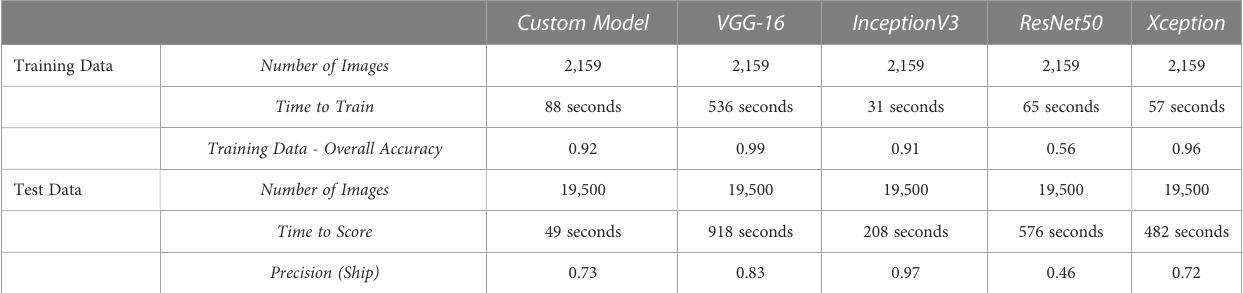
TABLE 3 System Evaluation Subsystem